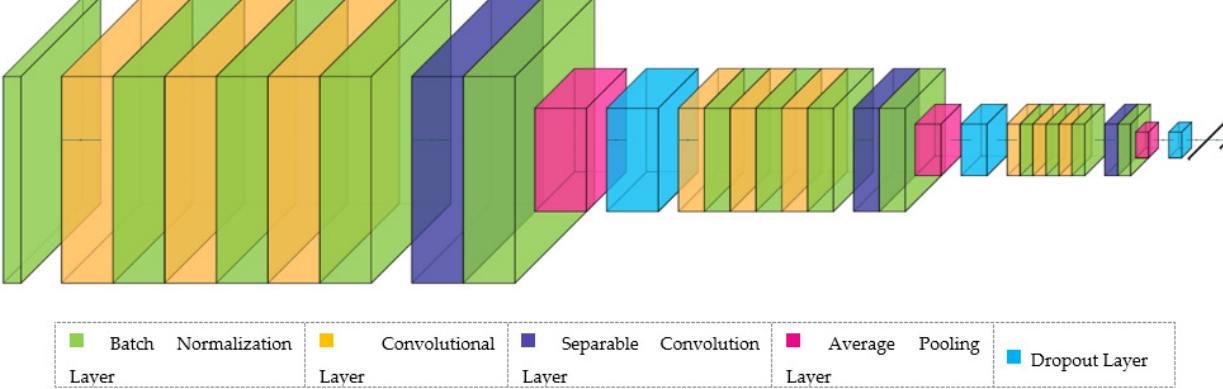
Figure 3. Developed CNN Model Architecture.